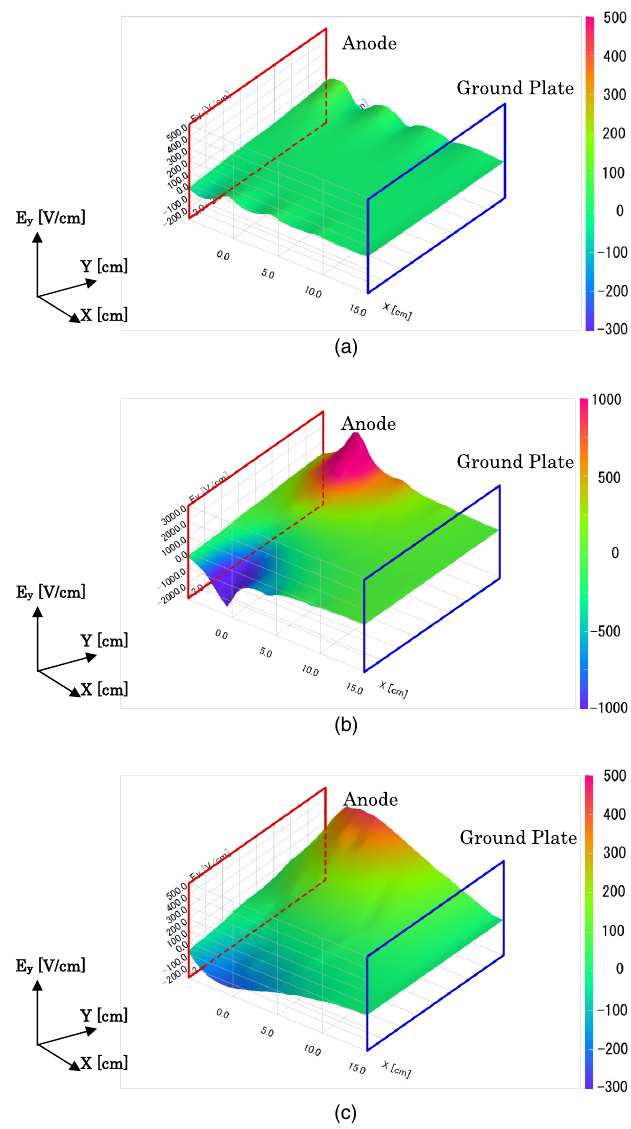
FIG. 8. (a) E y distribution on the kicker central plane at z ¼ 1150 mm for Model 0. (b) E y distribution on the kicker central plane at z ¼ 1150 mm for Model 1. (c) E y distribution on the kicker central plane at z ¼ 1150 mm for Model